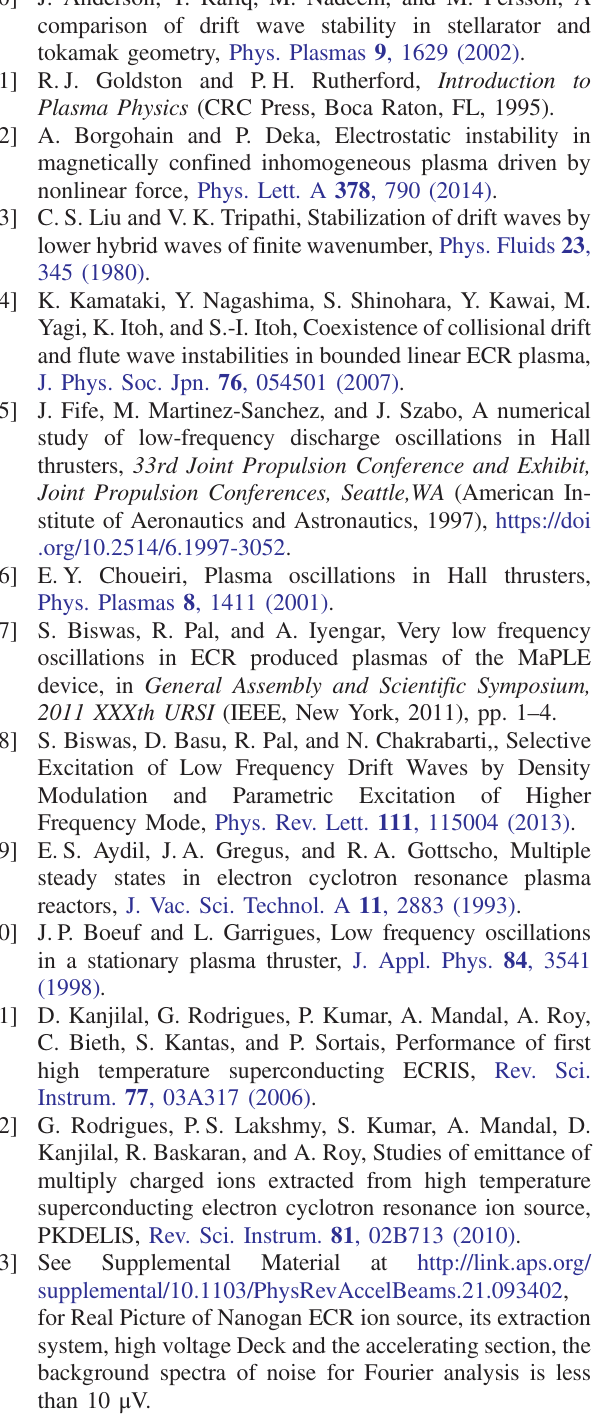
for Real Picture of Nanogan ECR ion source, its extraction system, high voltage Deck and the accelerating section, the background spectra of noise for Fourier analysis is less than 10 μ V. Correction: The numerical entries in the first row of Table II have been adjusted to correlate with values in Fig. 4. A typographical error in the inline equation appearing in the first sentence after Eq. (5) has been